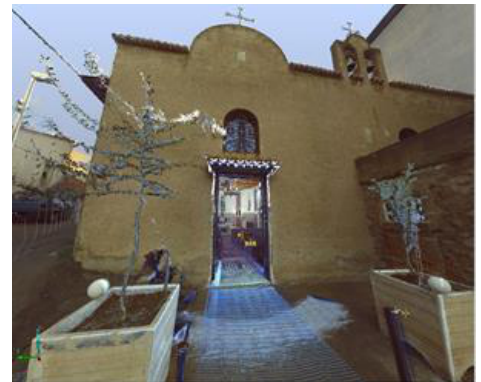
Figure 2. Recostruction 3D of Madonna dei Poveri’s church (chiesa Pepe), Reggio Calabria; outside